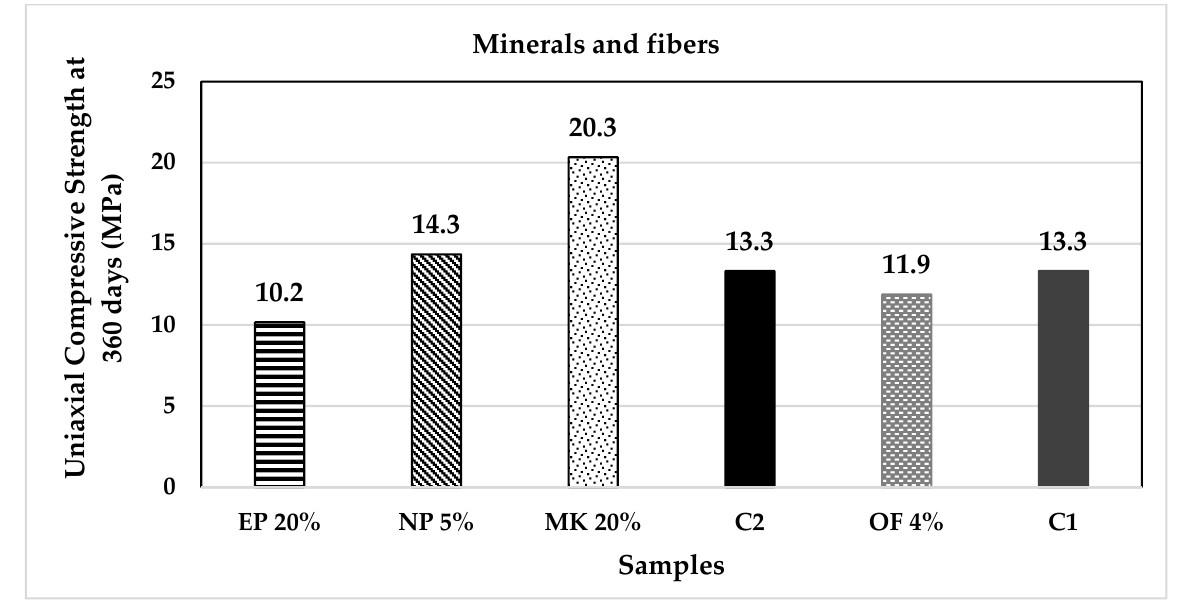
Figure 16. Uniaxial compressive strength of minerals and fibres group of additions.